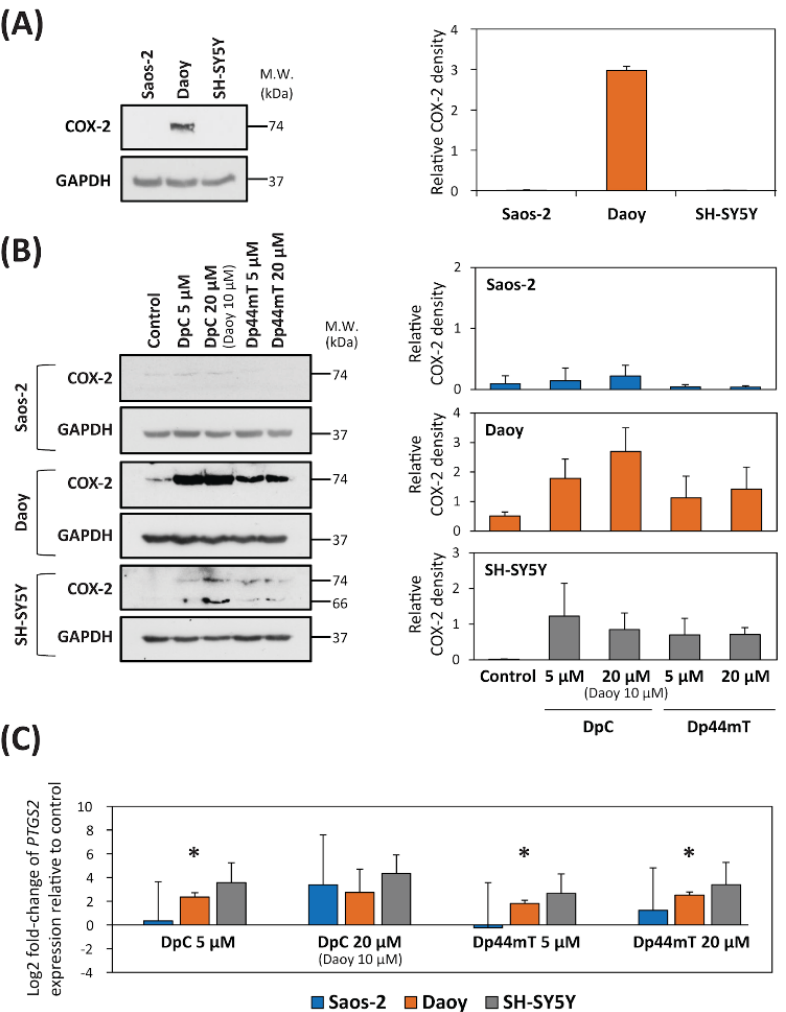
Figure 1. COX-2 expression is up-regulated at the ( A , B ) protein and ( C ) mRNA levels after incubation with DpC or Dp44mT for 24 h. ( A ) Western blot analysis of endogenous COX-2 levels in untreated (control) cells. GAPDH served as a protein loading control. ( B ) Western blot analysis of COX-2 levels in Saos-2, Daoy and SH-SY5Y cells after 24 h of incubation with either control medium, DpC (5 or 20 µ M; 10 µ M for Daoy cells—due to cytotoxicity) or Dp44mT (5 or 20 µ M). GAPDH served as a loading control. ( C ) The graph shows changes in the mRNA expression of PTGS2 in Saos-2, Daoy, or SH-SY5Y cells after 24 h of incubation with DpC or Dp44mT using the concentrations in ( B ). These data were obtained by RT-qPCR. The levels of mRNA expression after thiosemicarbazone treatment are presented as the log 2 fold change in mRNA levels relative to that of the untreated controls. GAPDH served as a reference control. For all experiments, expression was assessed in at least three biological replicates. Western blots are typical of three experiments, while the quantitation of the blots is presented as mean ± SD (3 experiments). These data were analyzed using an unpaired Welch’s t -test followed by the Games-Howell post hoc test. * p < 0.05 indicates significant di ff erences compared to the respective control